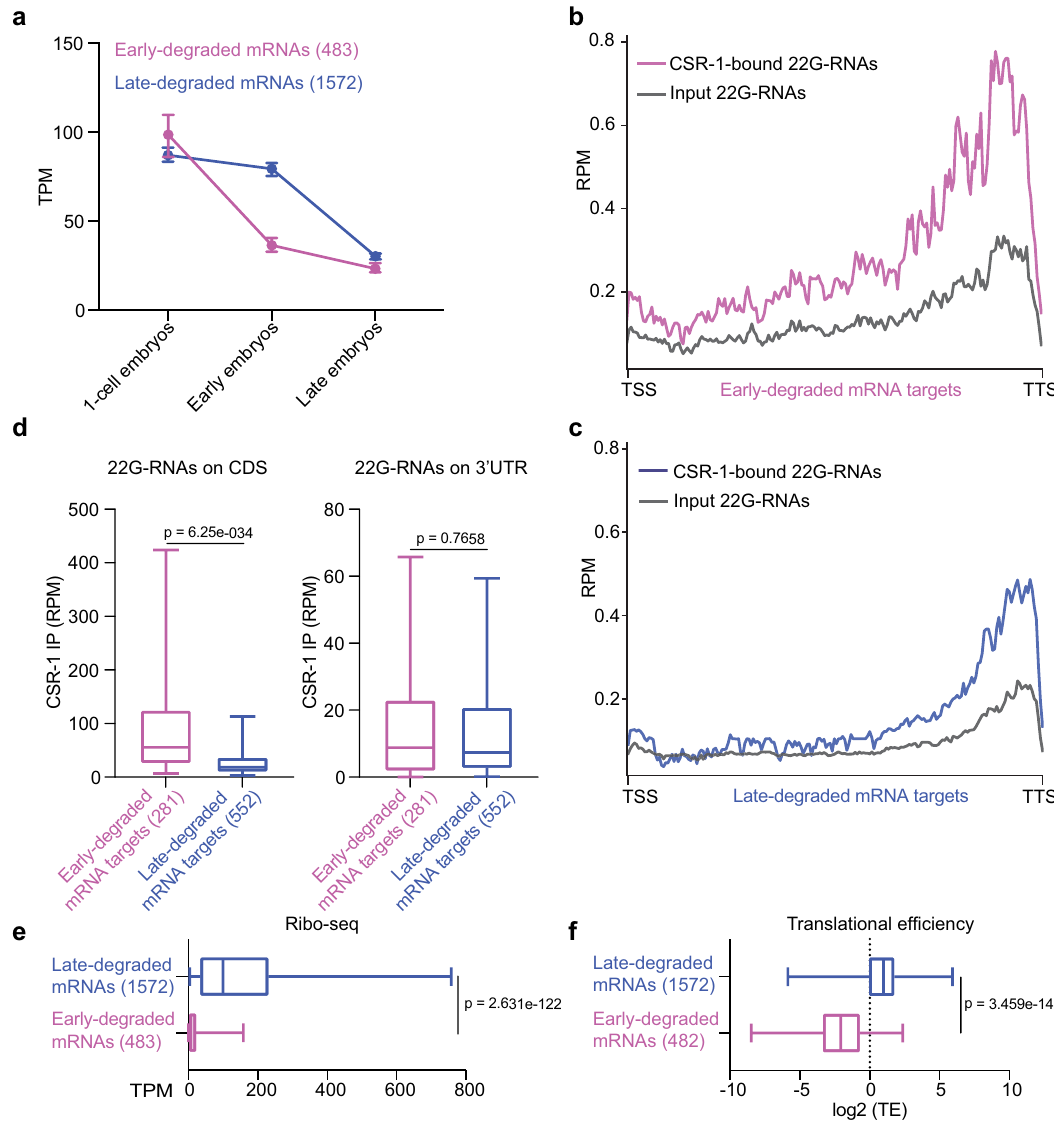
Fig. 5 CSR-1 preferentially targets maternal mRNAs no longer engaged in translation. a Detection of early- and late-degraded mRNAs by RNA-seq from sorted 1-cell, early and late embryo stages. Data are presented as median and 95% con fi dent interval of normalized read abundances in transcript per million (TPM). The sample size n (genes) is indicated in parentheses. b , c Metapro fi le analysis showing normalized 22G-RNA reads (RPM) across early- (magenta) and late-degraded (blue) mRNA targets in CSR-1 immunoprecipitation (IP) or total RNA input (gray). The transcriptional start site (TSS) and transcriptional termination site (TTS) is indicated. The average from three biologically independent replicates is shown. d Box plots showing the abundance of CSR-1-bound 22G-RNAs antisense to coding sequence (CDS) or 3 ′ UTR of early- and late-degraded mRNAs. e Box plots showing the ribosomal occupancy (by Ribo-seq) of early- and late-degraded mRNAs in early embryos. f Median levels and 95% CI of translational ef fi ciency (TE) of early- and late-degraded mRNAs in early embryos. In d – f , the line indicates the median value, the box indicates the fi rst and third quartiles, and the whiskers indicate the 5th and 95th percentiles, excluding outliers. The sample size n (genes) is indicated in parentheses. Two-tailed P value were calculated using